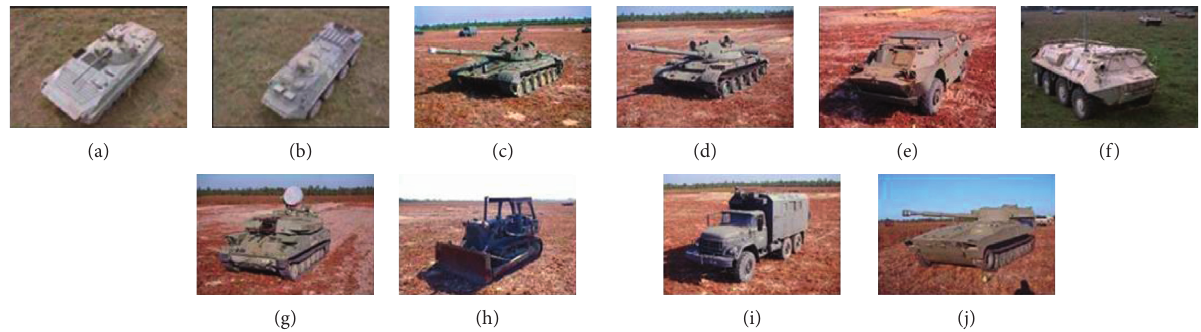
Figure 3: Optical images of MSTAR targets. (a) BMP2. (b) BTR70. (c) T72. (d) T62. (e) BRDM2. (f) BTR60. (g) ZSU23/4. (h) D7. (i) ZIL131. (j)